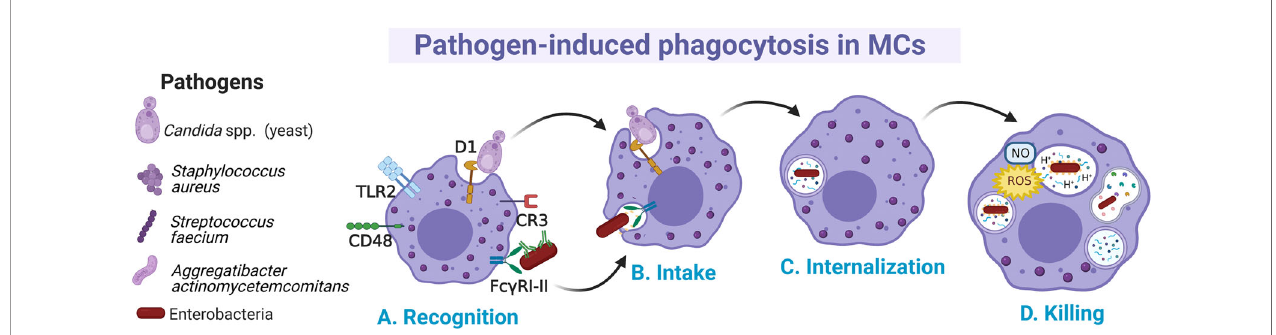
FIGURE 2 | Main events occurring during pathogen phagocytosis in MCs. (A) Several membrane receptors bind free or opsonized pathogens. After the recognition phase, (B) signal transduction pathways involving cytoskeletal re-arrangements lead to the intake of pathogens and (C) internalization into a phagocytic vesicle named phagosome. (D) Pathogens are killed by the fusion of phagosome with lysosomes and by the generation of nitric oxide (NO) and reactive oxygen species (ROS) as part of the respiratory